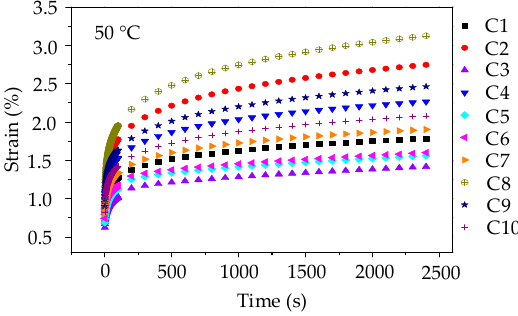
Figure 10. Strain-time curves of asphalt mixtures at 50 ° C.